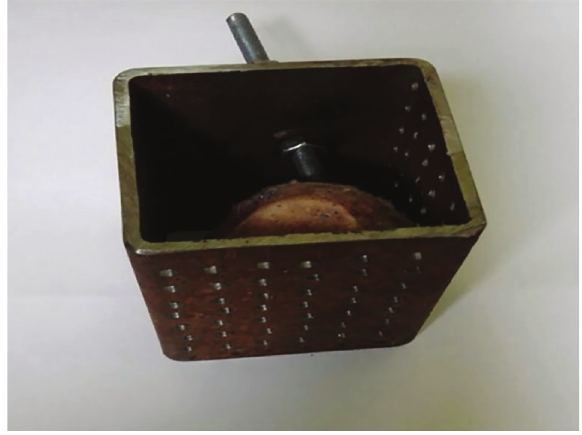
Figure 6 - Side view of a device for bone allograft channeling with subsequent impregnation of drugs into the bone tissue with femoral bone head fixed in it